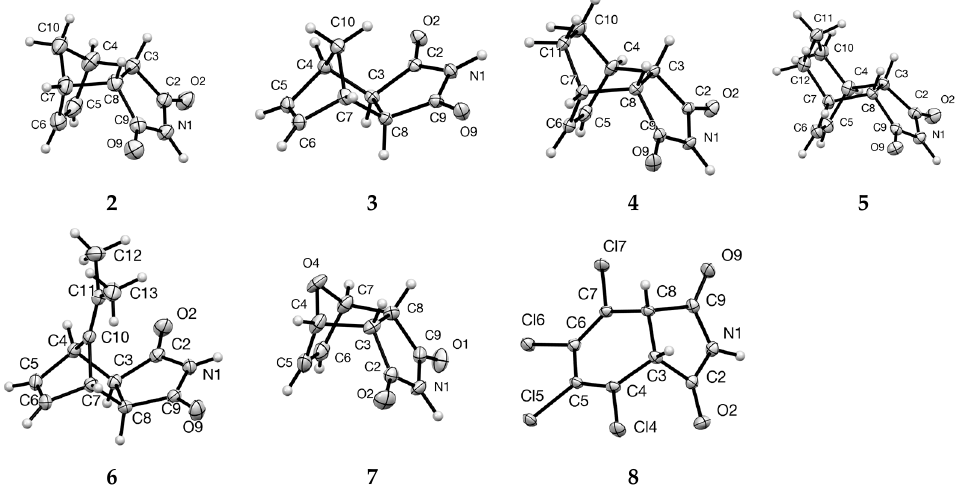
Figure 5. Molecular structures for Diels–Alder derived compounds 2–8 showing numbering systems used (50% probability ellipsoids).